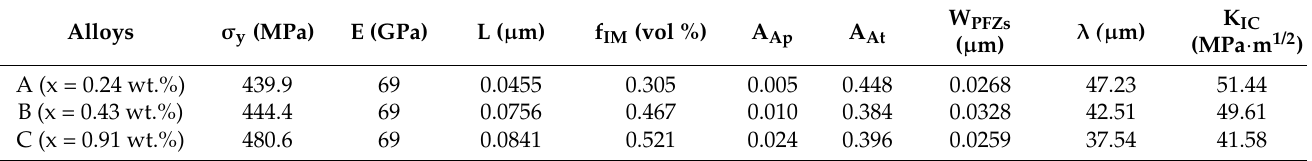
Table 8. Relevant parameter values of Al-5Zn-2.6Mg-xCu